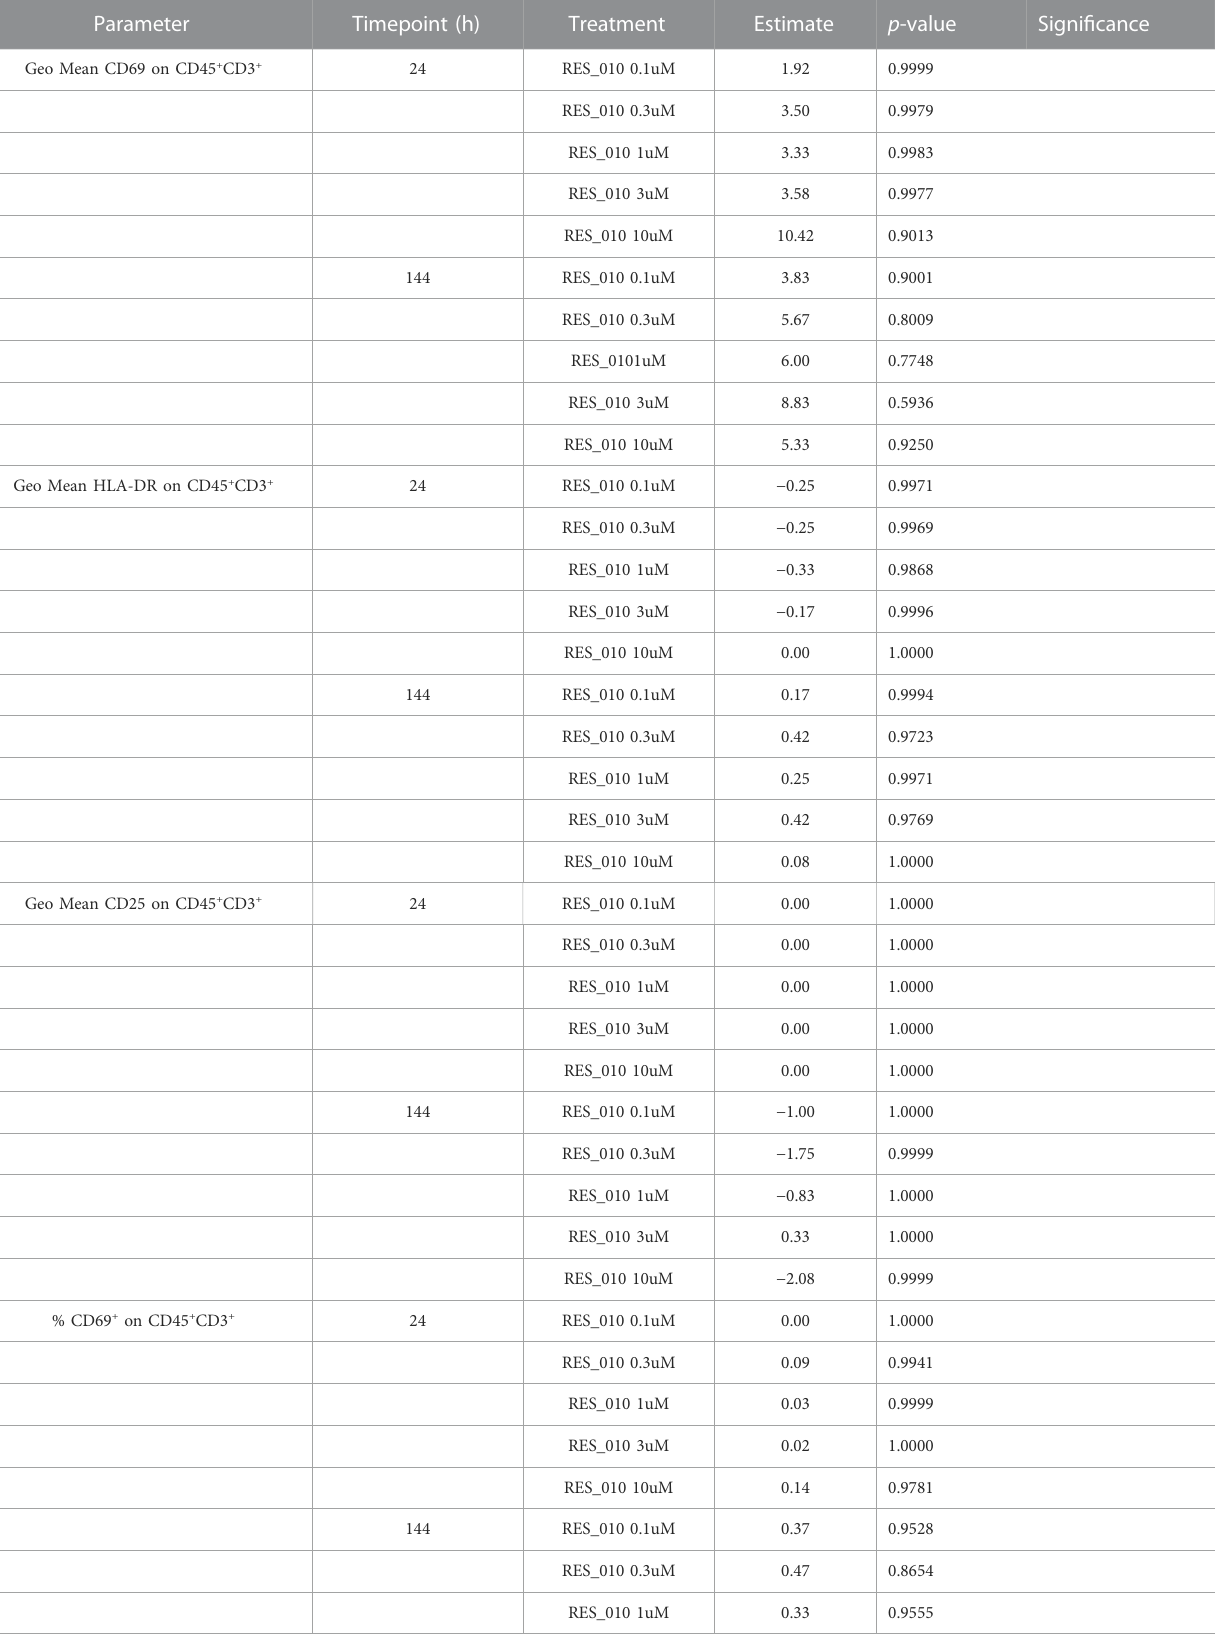
TABLE 9 Statistical Result of Compound Effect vs.